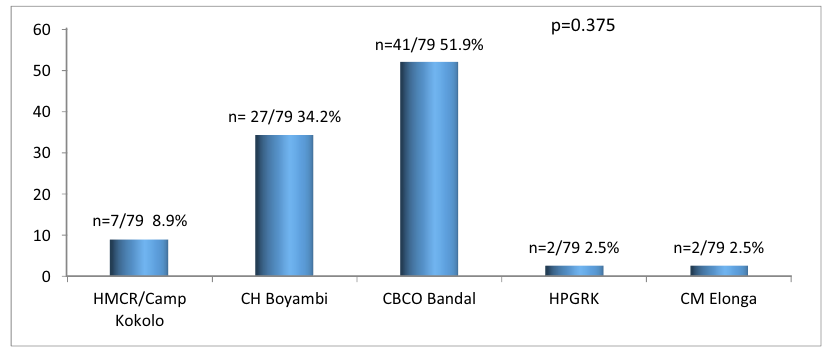
Fig. 1. Prevalence of dental cellulitis according to the